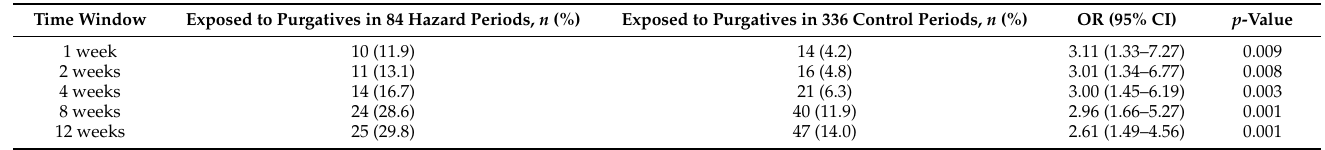
Table 3. Association of bowel preparation and subsequent colonoscopy with new-onset atrial fibrilla- tion according to time